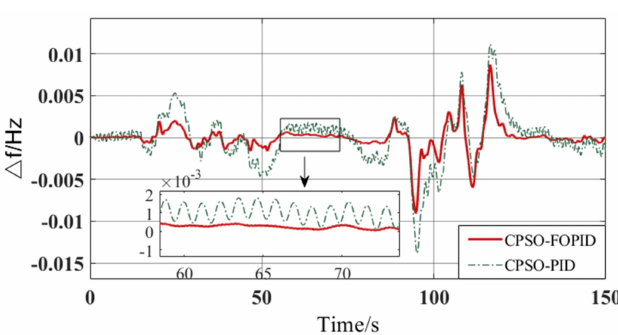
Figure 7. Frequency variation curve of the power grid under random disturbances of the wind